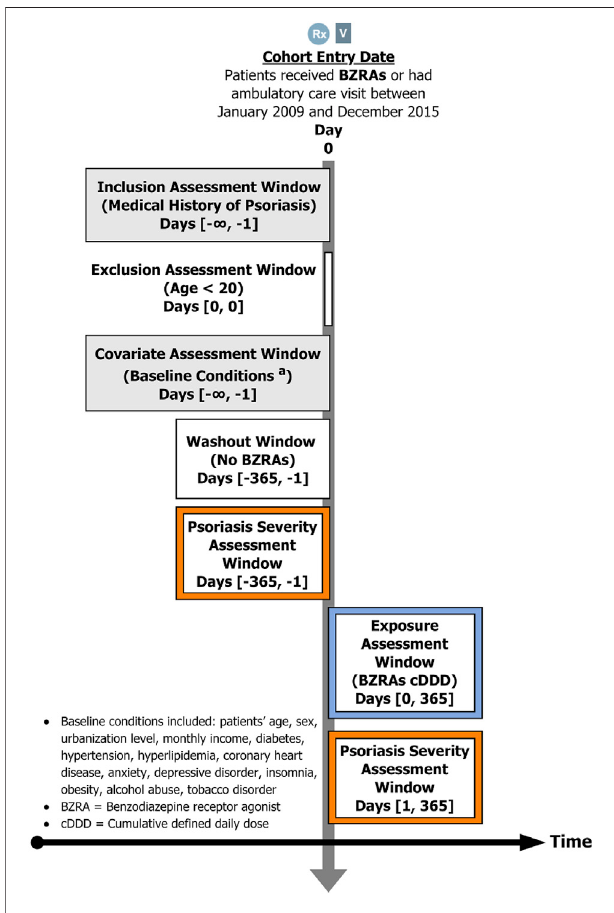
FIGURE 1 | The design of the